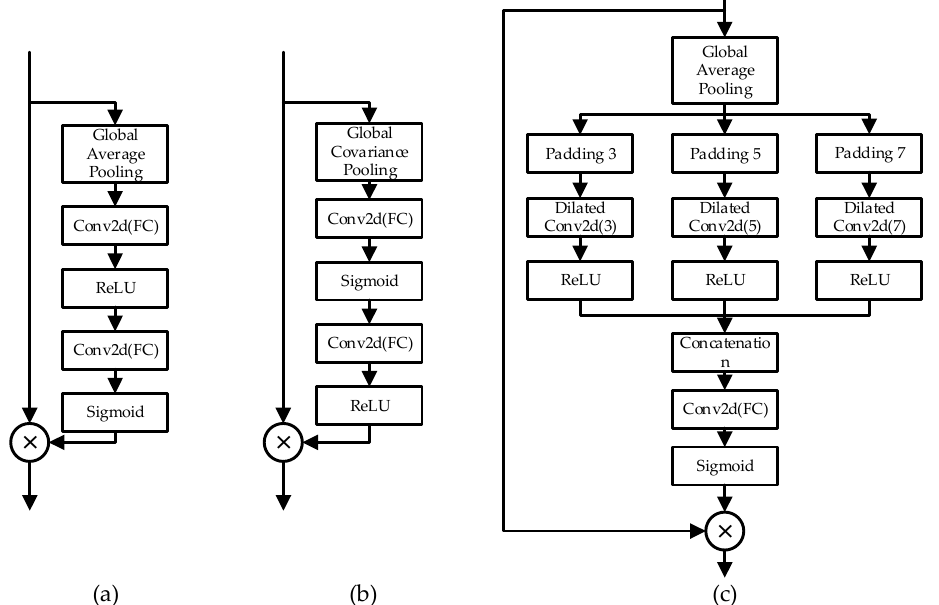
Figure 1. The detailed structure of channel attention mechanisms. ( a ) Channel attention in RCAN, ( b ) Second-order channel attention in SAN, ( c ) Laplacian pyramid attention in DRLN.